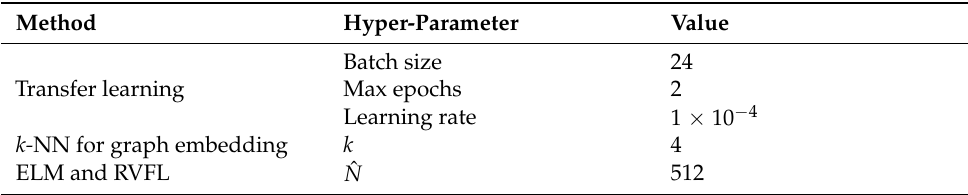
Table 3. Hyper-parameter settings in the